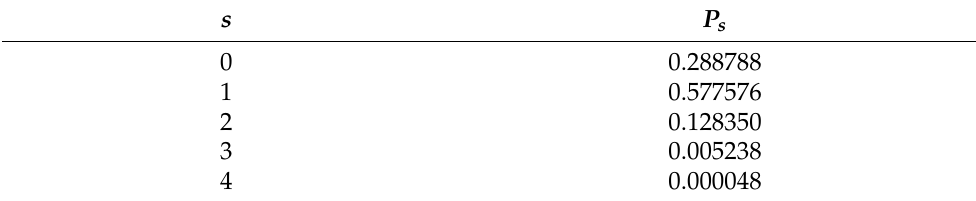
Table 1. Rank distribution of the random binary square